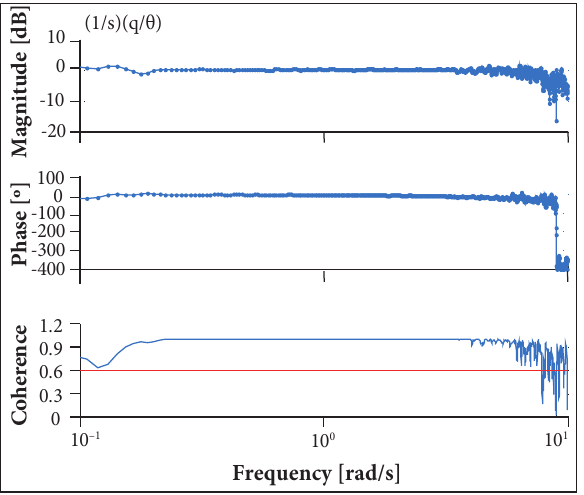
Figure 7. Frequency-domain angular consistency – longitudinal axis.